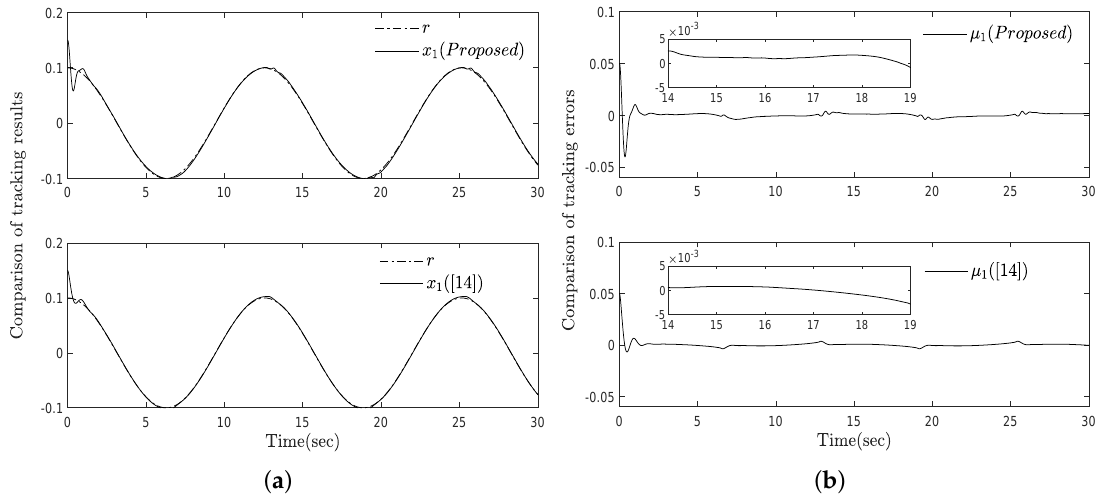
Figure 6. Comparison of tracking results and errors for Example 2 ( a ) x 1 and r ( b ) µ 1 .